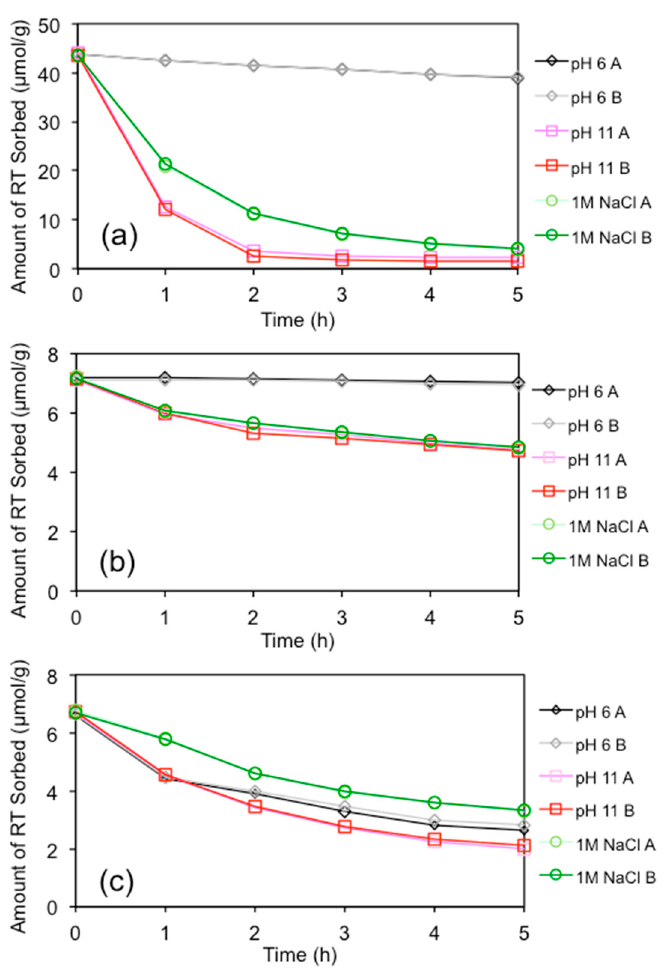
Figure 3. Desorption of RT from ( a ) Pal, ( b ) Kao, and ( c ) talc.